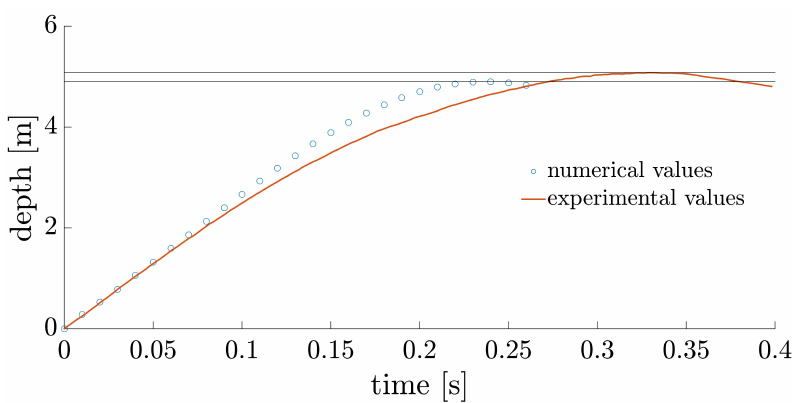
Figure 14. Off-centred impact: block’s displacement according to time for an impacting energy of 270 kJ.